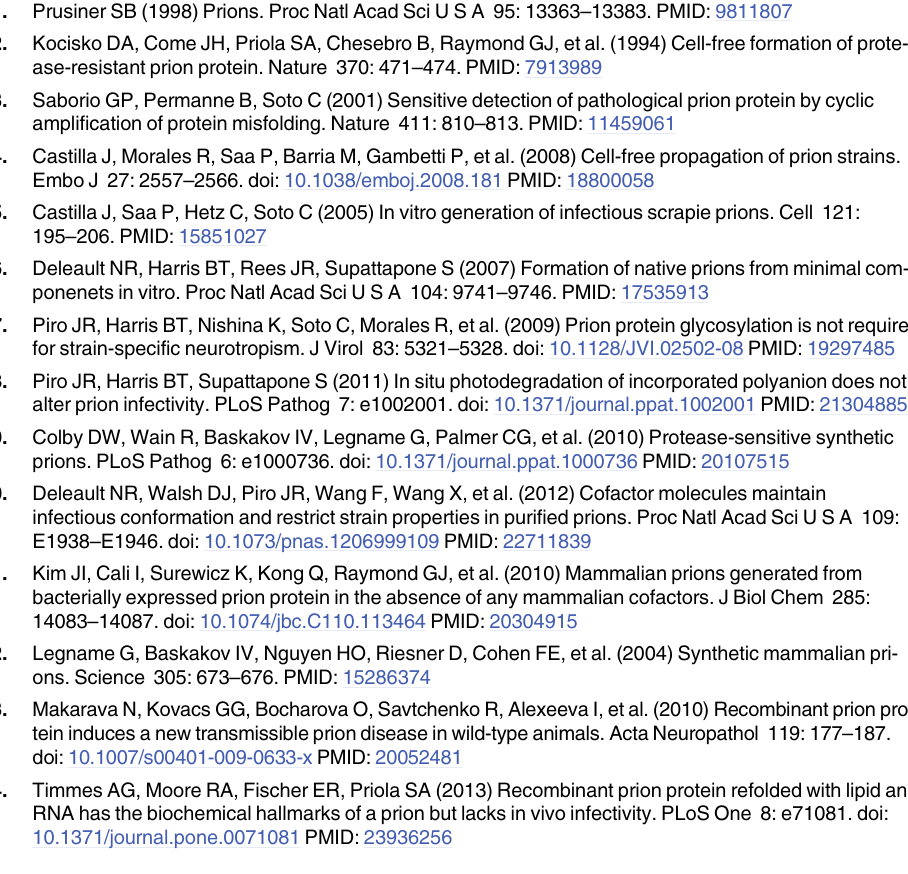
S9 Fig. Biological replicate of deglycosylated PrP C sPMCA conversion using cofactor and protein-only PrP Sc seeds. Western blot showing three round sPMCA reactions using partially purified and deglycosylated PrP C as the substrate and seeded with protein-only PrP Sc , cofactor PrP Sc , or prion-infected brain homogenate, as indicated. This represents a biological replicate of the experiment shown in Fig 5. All samples shown are from an identical exposure/image of a single membrane, with irrelevant samples removed so that the experimental samples are adja- cent to one